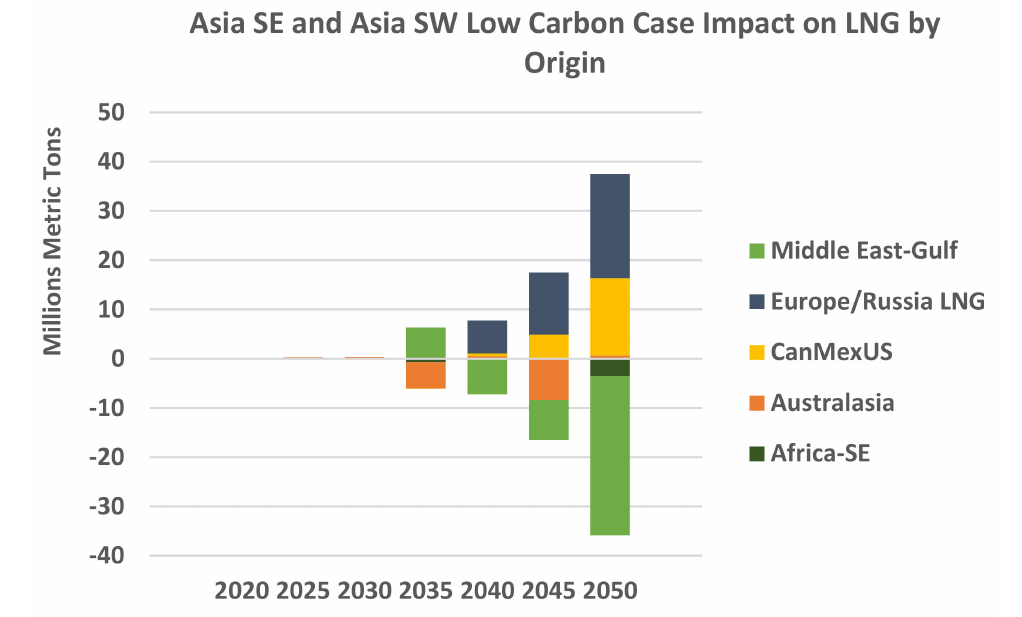
Figure 27. NE Asia total LNG by origin in base vs. low-carbon